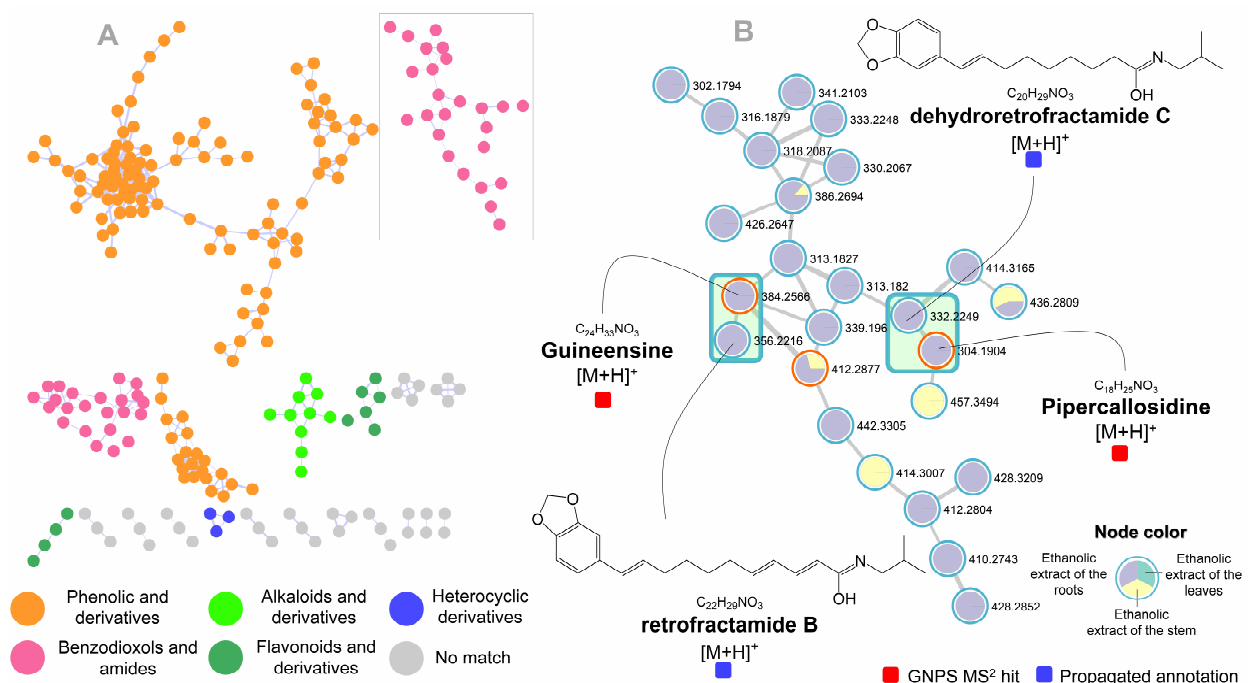
Figure 1. ( A ) Classification of compounds classes and subclasses of the ethanolic extract from P. pellucida leaves, stem, and roots using MolNetEnhancer [34]; ( B ) Some examples of propagated annotation using Sirius 4 [35].